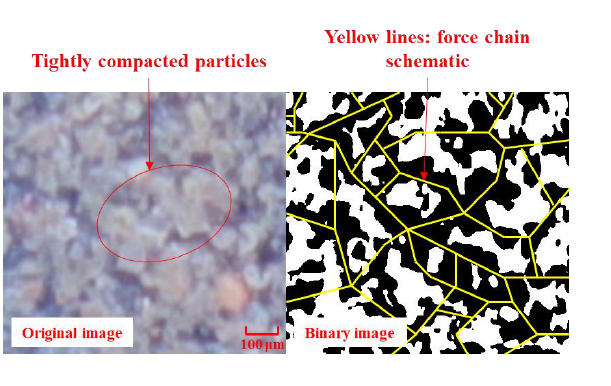
Figure 10. Mesostructure of tailings specimen with 15% moisture content under continuous load: ( a ) 0 s; ( b ) 1500 s; ( c ) 1700 s; ( d ) 3000 s.